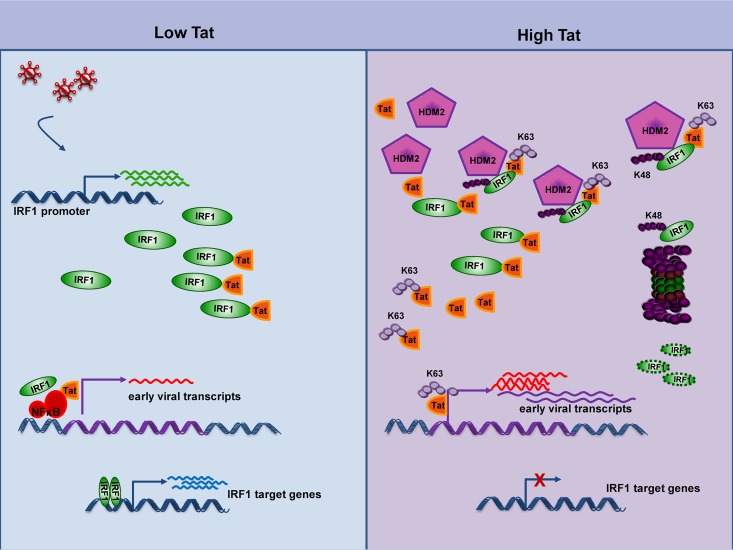
Schematic representation of the dual effect of Tat on IRF-1 activity in the course of HIV-1 infection. In early phases of HIV-1 replication, IRF-1 is transcriptionally stimulated by viral infection, and it is recruited by small amounts of Tat on the viral promoter to drive, with NF-κB, initial transcription of the integrated provirus. Later, when discrete amounts of Tat are produced and IRF1 activity on LTR is dispensable for the virus to replicate, Tat nullifies the function of IRF-1, accelerating its proteasome-mediated degradation upon recruitment of the HDM2 E3 ligase, thus quenching its activity on target gene promoters.